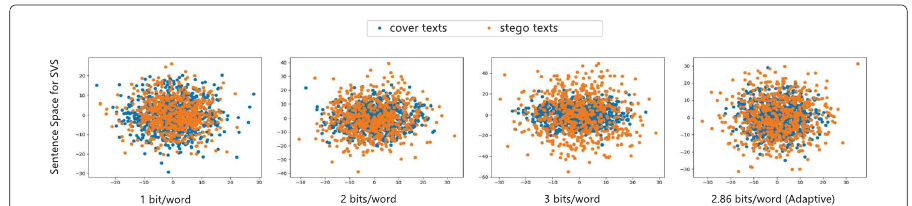
Fig. 5 The distribution difference between the stego text generated by SVS and the cover text without embedding in the semantic space under different embedding